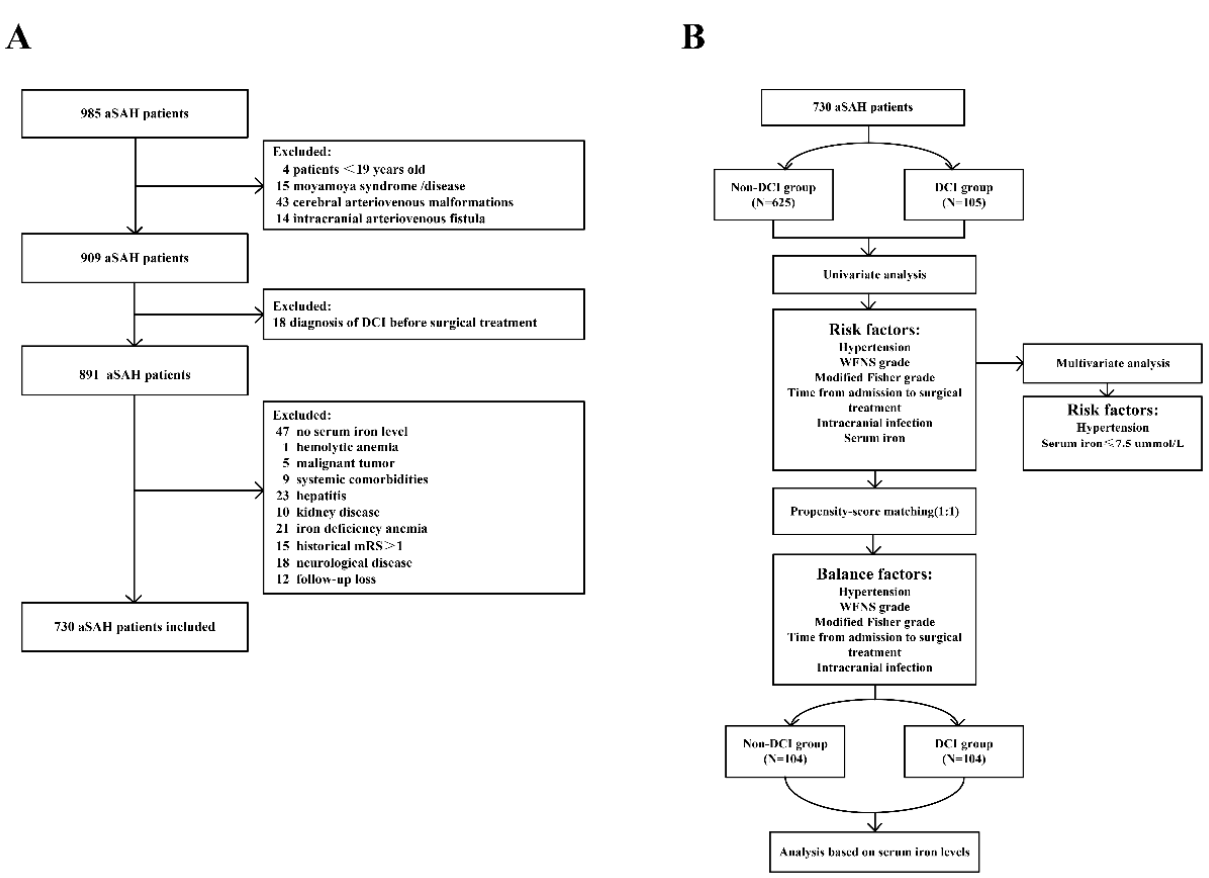
Figure 1. ( A ) Flow diagram of the patient selection process; ( B ) Flowchart of propensity-score matching. aSAH: aneurysmal subarachnoid hemorrhage; DCI: delayed cerebral ischemia; mRS: modified Rankin Scale; WFNS: world federation of neurosurgical societies.